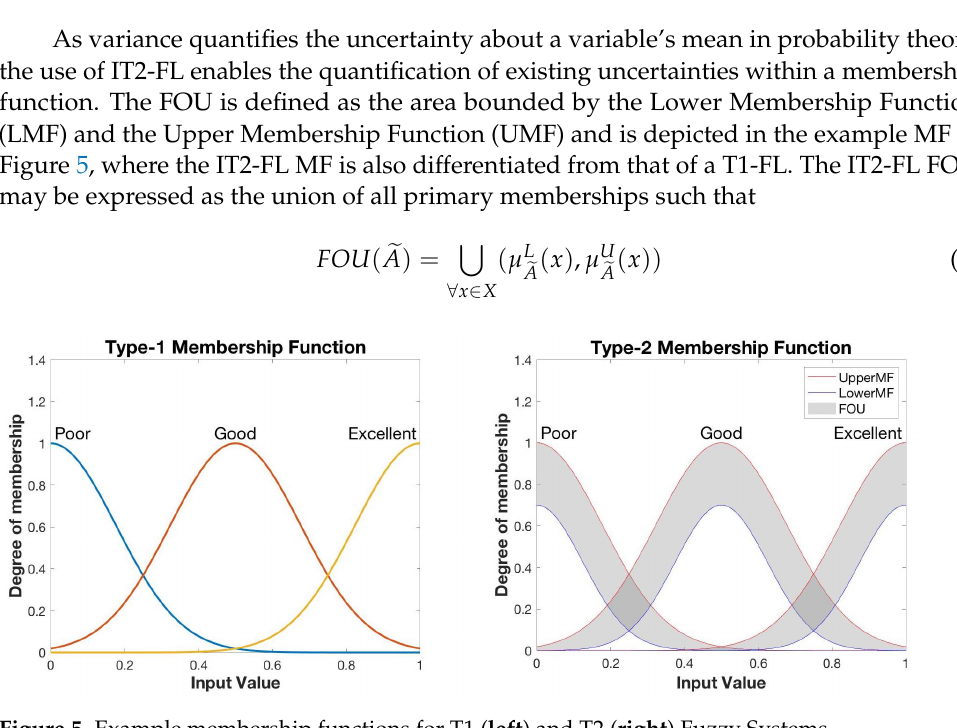
Figure 4. Example of a GT2-FL ( left ) vs. IT2-FL ( right ) Fuzzy Set.